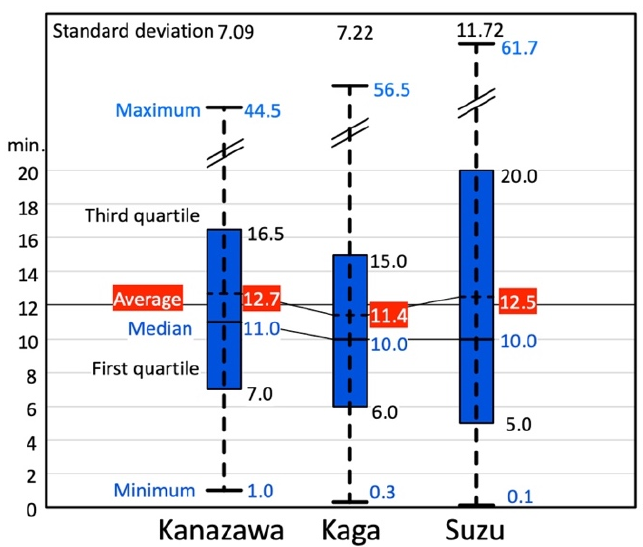
Figure 8. Distribution of all single outing times for participants in three target cities by transportation (unit: minutes).